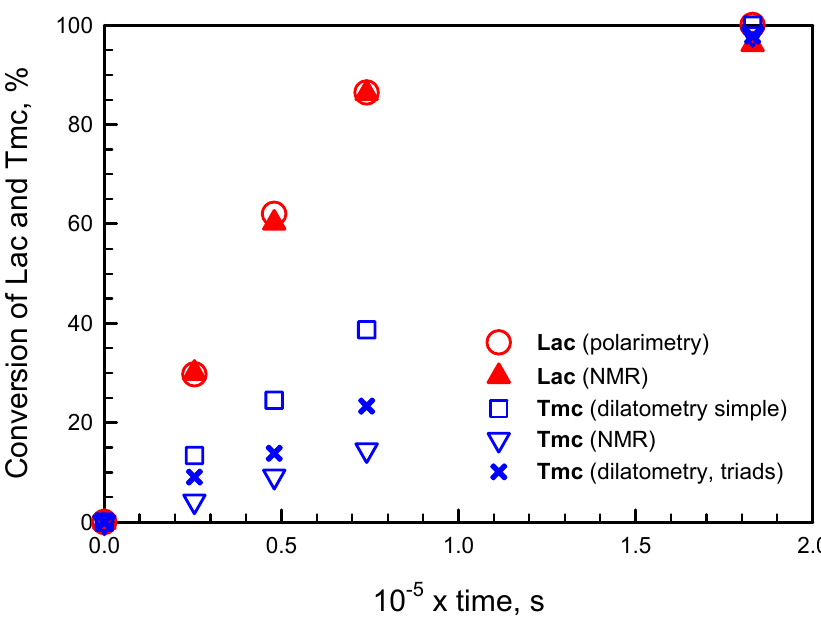
Figure 12. Evolution of Lac and Tmc conversions in system initiated by mixture of R - and S - Ini (conditions given in Figure 10) determined by 13 C NMR, polarimetry, and two dilatometric methods: a simple (assuming equal volume contraction coefficients) and devised by us taking into account triad dependence of CC (and assuming CC TTL + CC LTT = CC TTT + CC LTL , as well as k TTR ≠ k TTS ).